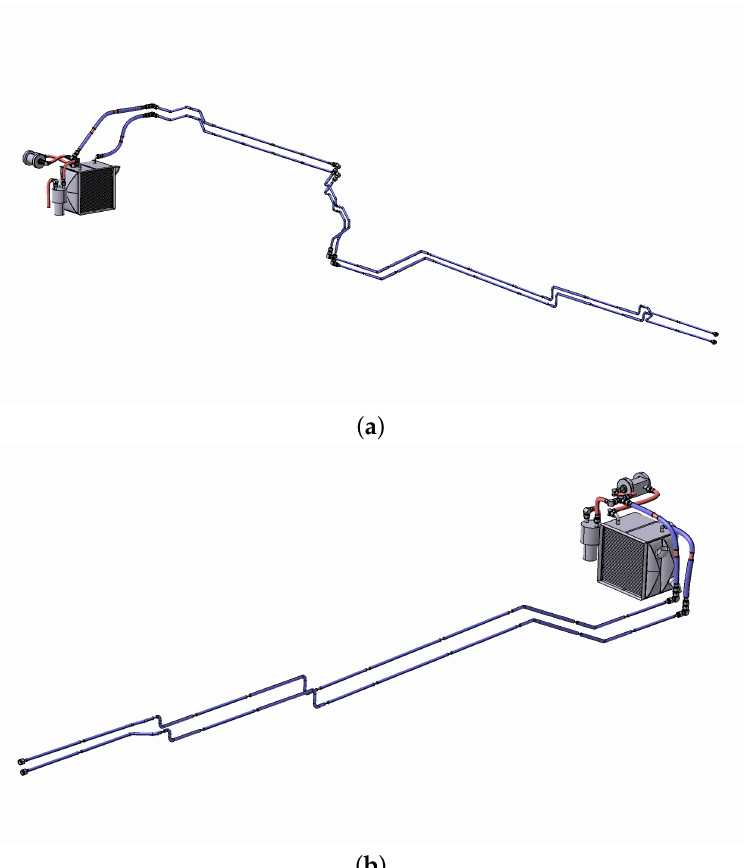
Figure 5. Use-case geometry models representing the two different routing options under inves- tigation. The piping reaches from the LHEX to the front of the aircraft where the radar is located. The radar is not included in either ( a ) or ( b ): ( a ) geometry model of cooling power distribution system routing option one ( Configuration 1 ). The ECS is located in the aft of the aircraft; ( b ) geometry model of cooling power distribution system routing option one ( Configuration 1 ). The ECS is located in the aft of the